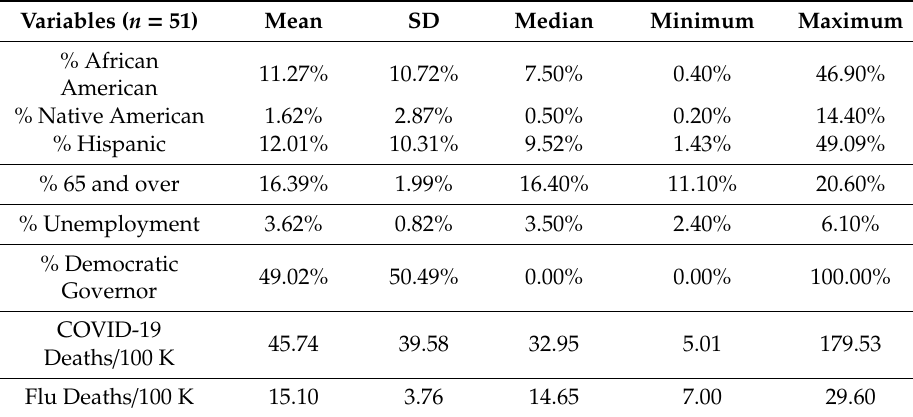
Table 3. State level descriptive